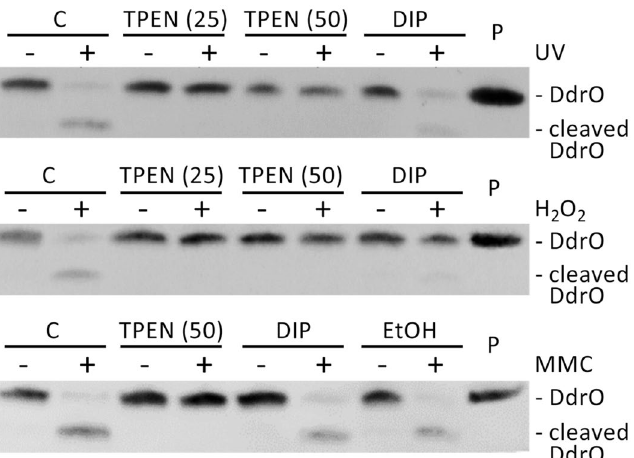
Figure 2. Stress-induced DdrO cleavage in D. deserti requires zinc ions. D. deserti strain RD19 (wild type) was exposed or not to UV (250 J/m 2 ), H 2 O 2 (10 mM for 10 min) or MMC (1 μg/ml for 10 min) in the presence of the Zn 2+ chelator TPEN (25 or 50 μM) or the Fe 2+ chelator DIP (500 μM), and DdrO cleavage was analyzed by immunoblotting. Because TPEN was dissolved in ethanol (EtOH), a control with EtOH (0.5% final concentration) was included. C, control without metal chelator. P, 20 ng purified DdrO. Each cropped blot corresponds to a single independent blot; the three uncropped blots are shown in Supplementary Fig.